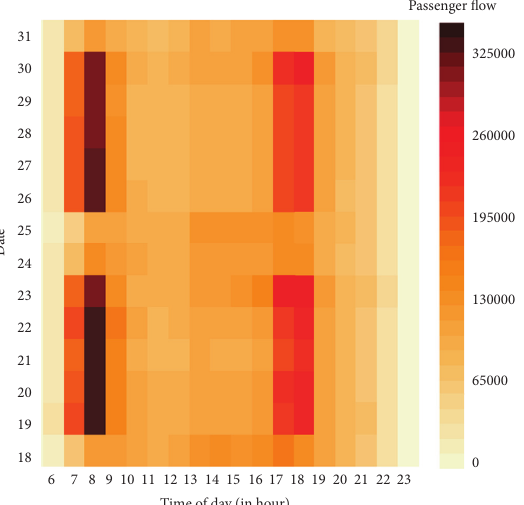
Figure 7: Heat map of hourly subway ridership.